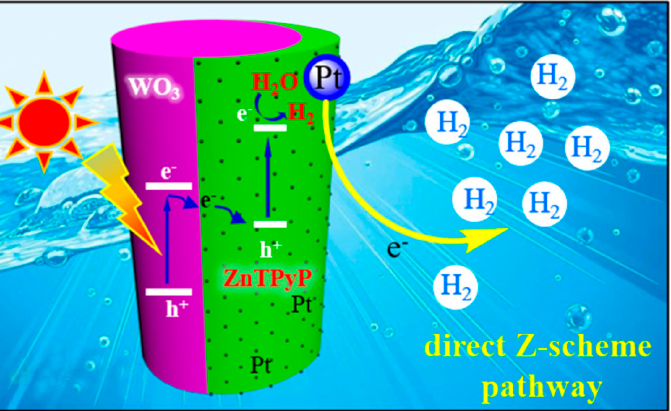
Figure 4. Photocatalytic mechanism scheme and the possible charge separation of direct Z-scheme ZnTPyP/WO 3 [30].